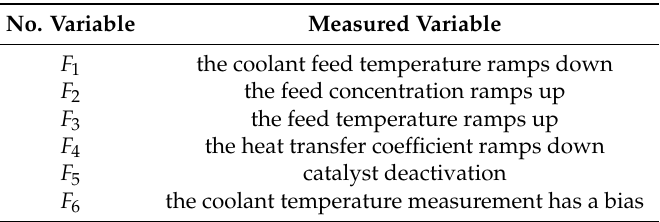
Table 3. Fault Description of the CSTR Process.